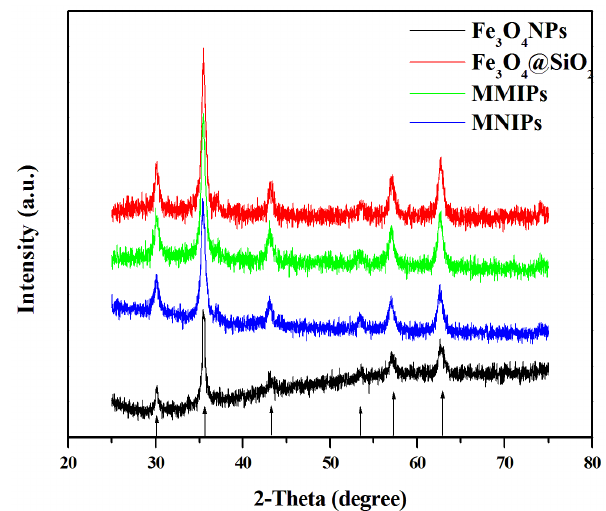
Figure 5. XRD spectra of the four polymers (Fe 3 O 4 NPs, Fe 3 O 4 @SiO 2 , MMIPs, and MNIPs).